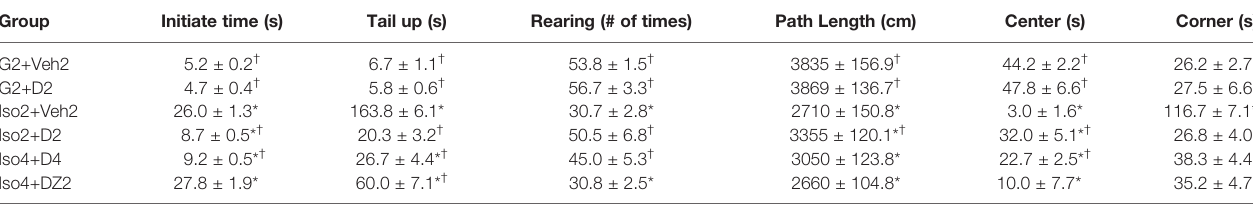
Quanti fi cationsofanxiety-likebehaviorinsociallyisolatedmiceandDHMtreatment.Initialtime(freezing):thetimedurationfromwhenthemouse fi rstplacedintothecenteroftheapparatus tostart moving. Tailup: the timeof tail lifting.Rearing: totalnumber oftimes ofrearings. Pathlength: totaldistance ofmoving. Center: thetotaltime durationthemouse stayed inthecenter 20x20 cm squares. Corner: the total duration the mouse stayed in the 4 corner 10x10 cm squares. *, p ≤ 0.05 vs. vehicle group housing control. † , p ≤ 0.05 vs. Iso2+Veh2, (n = 6/group, one-way ANOVA followed by multiple comparison, Holm-Sidak